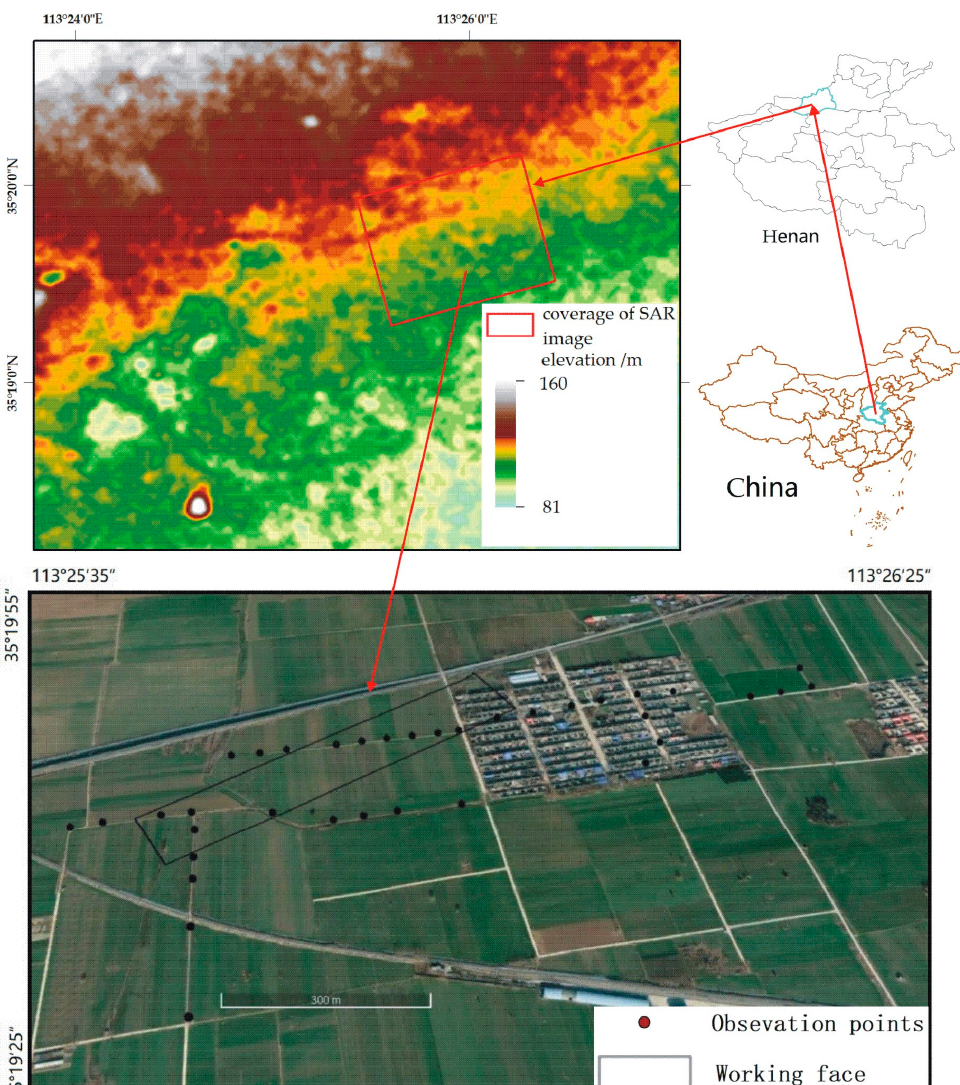
Fig 5 Figure 5. Location and image of the study area. The black rectangle is the working face of the mine, and the black dots are the leveling